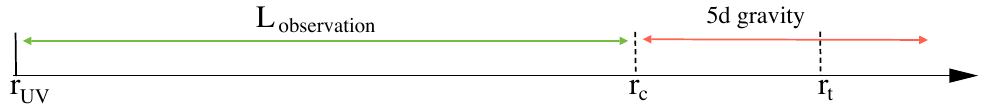
Figure 12 . The horizontal direction represents the hierarchy of distance scales in the DGP scenario. The regime corresponding to the observed massless 4d gravity is represented in green. At distances of the order r c we have a large-distance transition to the (cid:12)ve-dimensional regime. For this scenario to be compatible with observation, if we want to be conservative